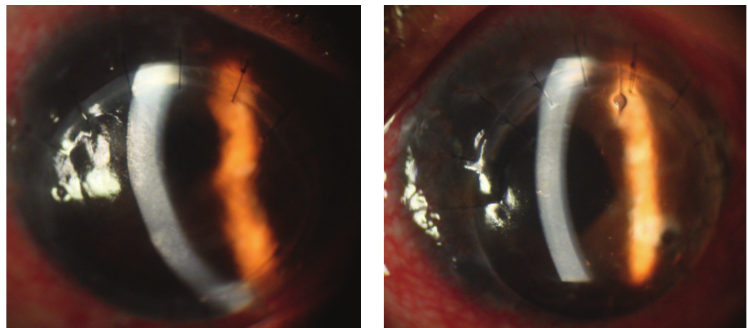
Figure 3: Right and left eyes after repeated penetrating keratoplasty and cataract extraction with intraocular lens implant, September 2010.